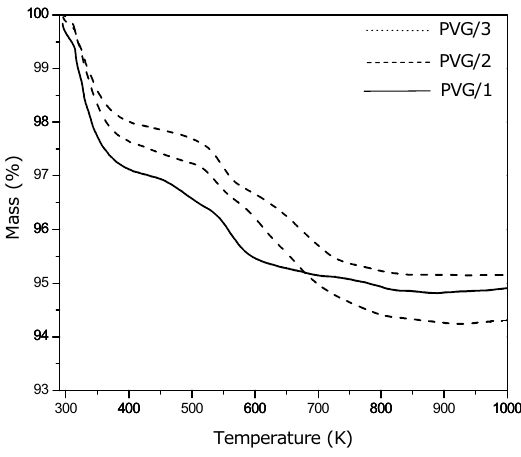
Fig. 4 – TG curves of samples: PVG/ 1 , PVG/ 2 and PVG/ 3 .